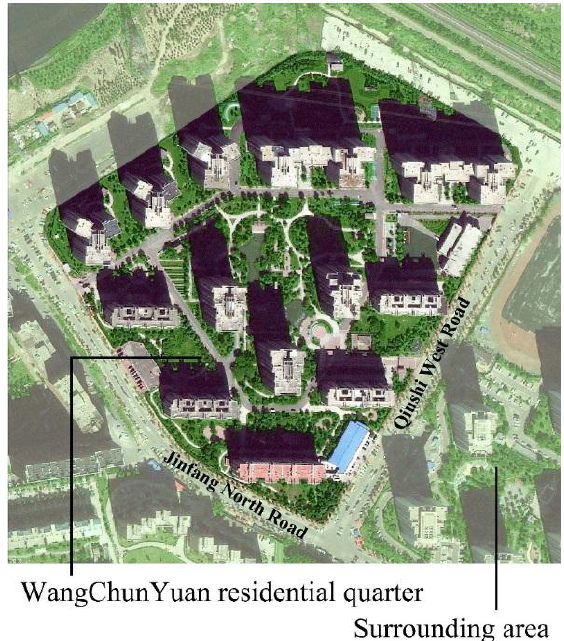
Figure 1 . BaiduMap image of Wangchunyuan (WCY) residential quarter.